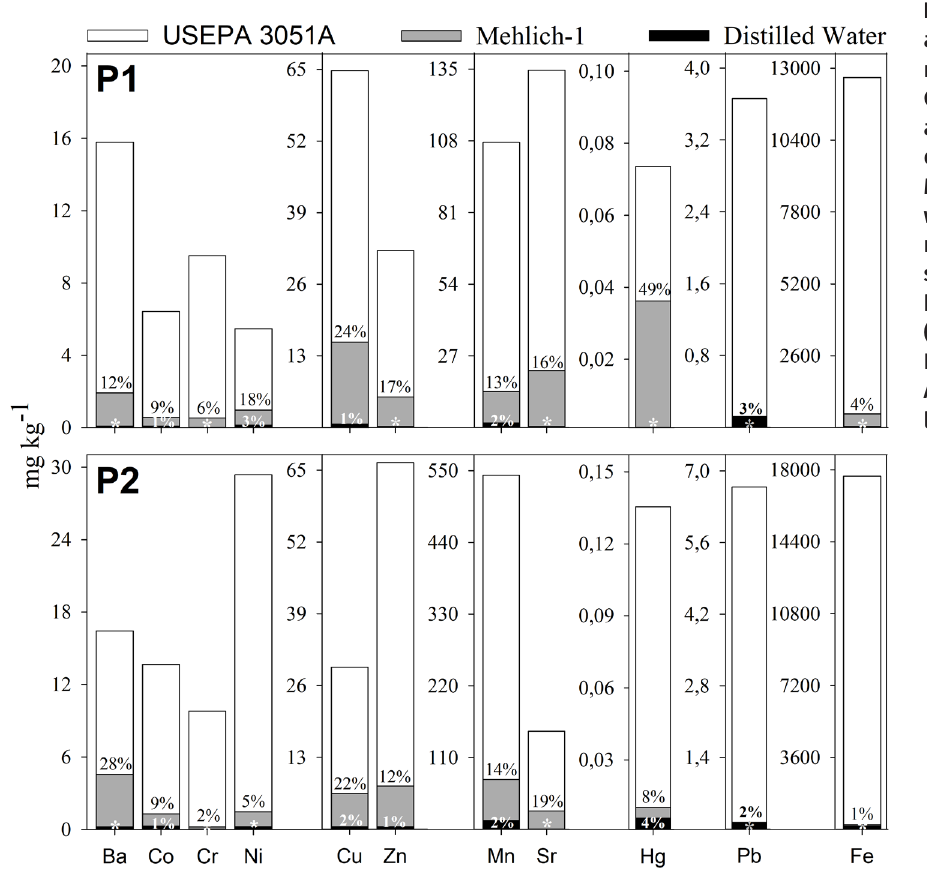
Figure 7. Average values and percentage of the metals (Ba, Co, Cr, Ni, Cu, Zn, Mn, Sr, Hg, Pb and Fe) extracted by distilled water and Mehlich-1 compared with the USEPA 3051A method from soil samples influenced by gentoo penguins (P1 and P2) in the Livingston Island, Antarctica. * percentage lower than